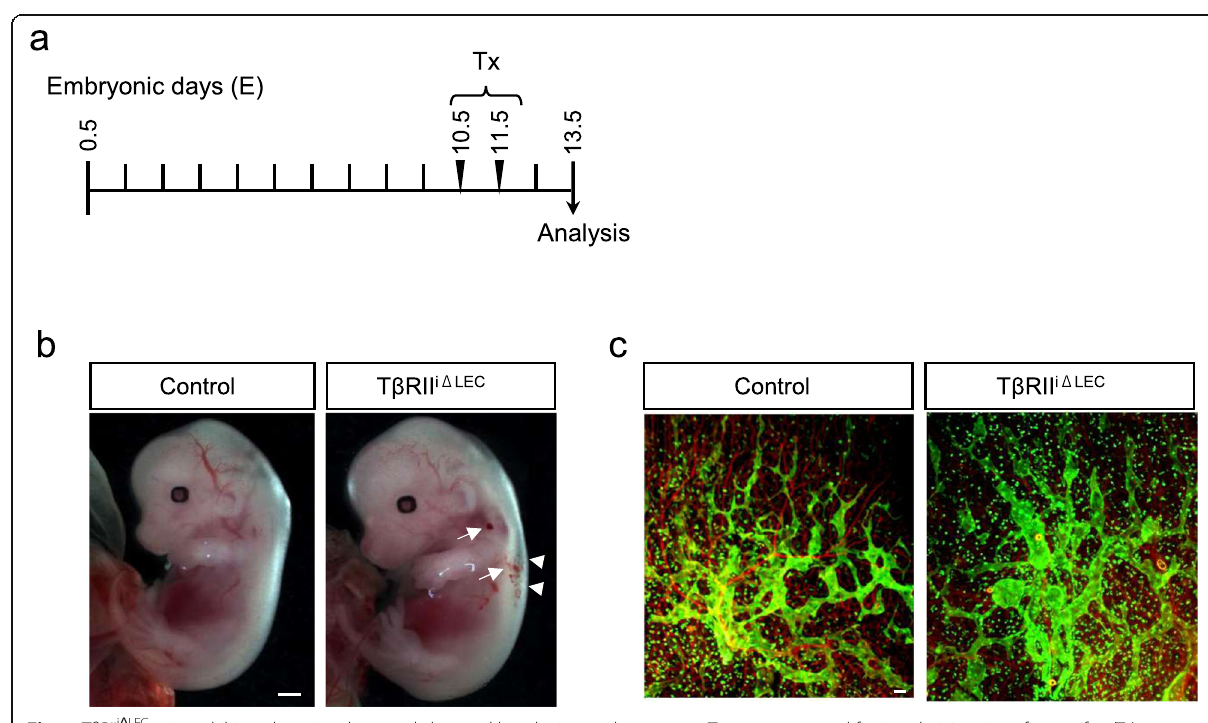
Fig. 1 T β RII i Δ LEC mice exhibit embryonic edema and abnormal lymphatic vessel structure. a Treatment protocol for i.p. administration of tamoxifen (Tx). Pregnant mice were injected with Tx at E10.5 and E11.5, and embryos were analyzed at E13.5. b Gross analysis of T β RII fl/fl ; Prox1-CreER T2 (T β RII i Δ LEC ), and littermate control (T β RII fl/fl ) embryos at E13.5. Mild edema (arrowhead) and blood clots (arrows) are observed in T β RII i Δ LEC pups. Scale bar: 1 mm. c . Back skin immunohistochemistry of mice embryos at E13.5 with anti-LYVE-1 (green) and anti-PECAM-1 (red) antibodies. Scale bar: 100 μ